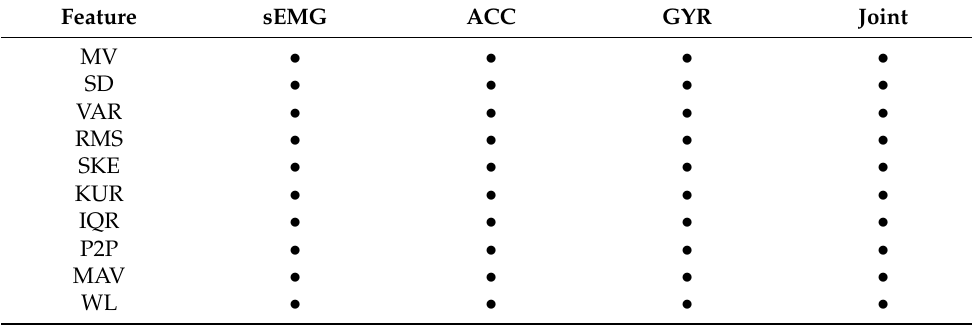
Table 2. The initial select feature sets of each sensor data